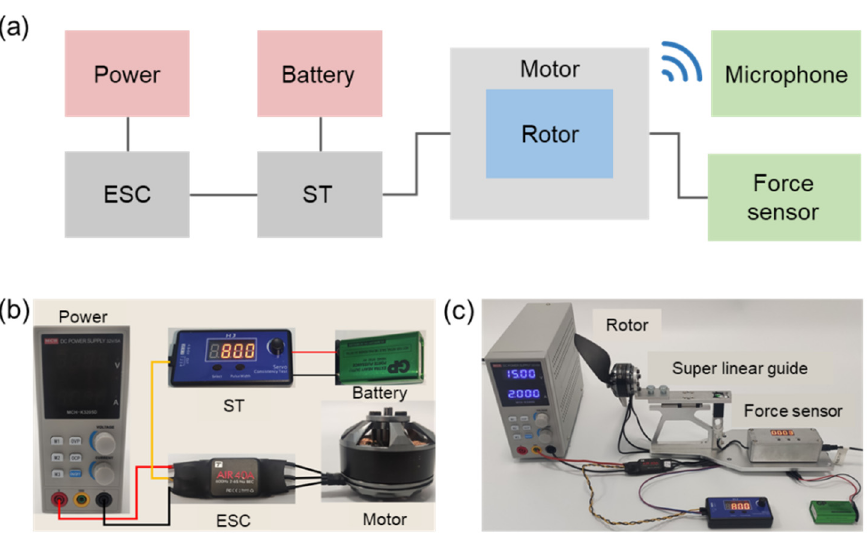
Figure 6. Experimental test setup. ( a ) Workflow of the test setup for aerodynamic and acoustic performance; ( b ) The connection state of the main components in the DTS; ( c ) DTS assembled with the RTTP at the stand-by state.